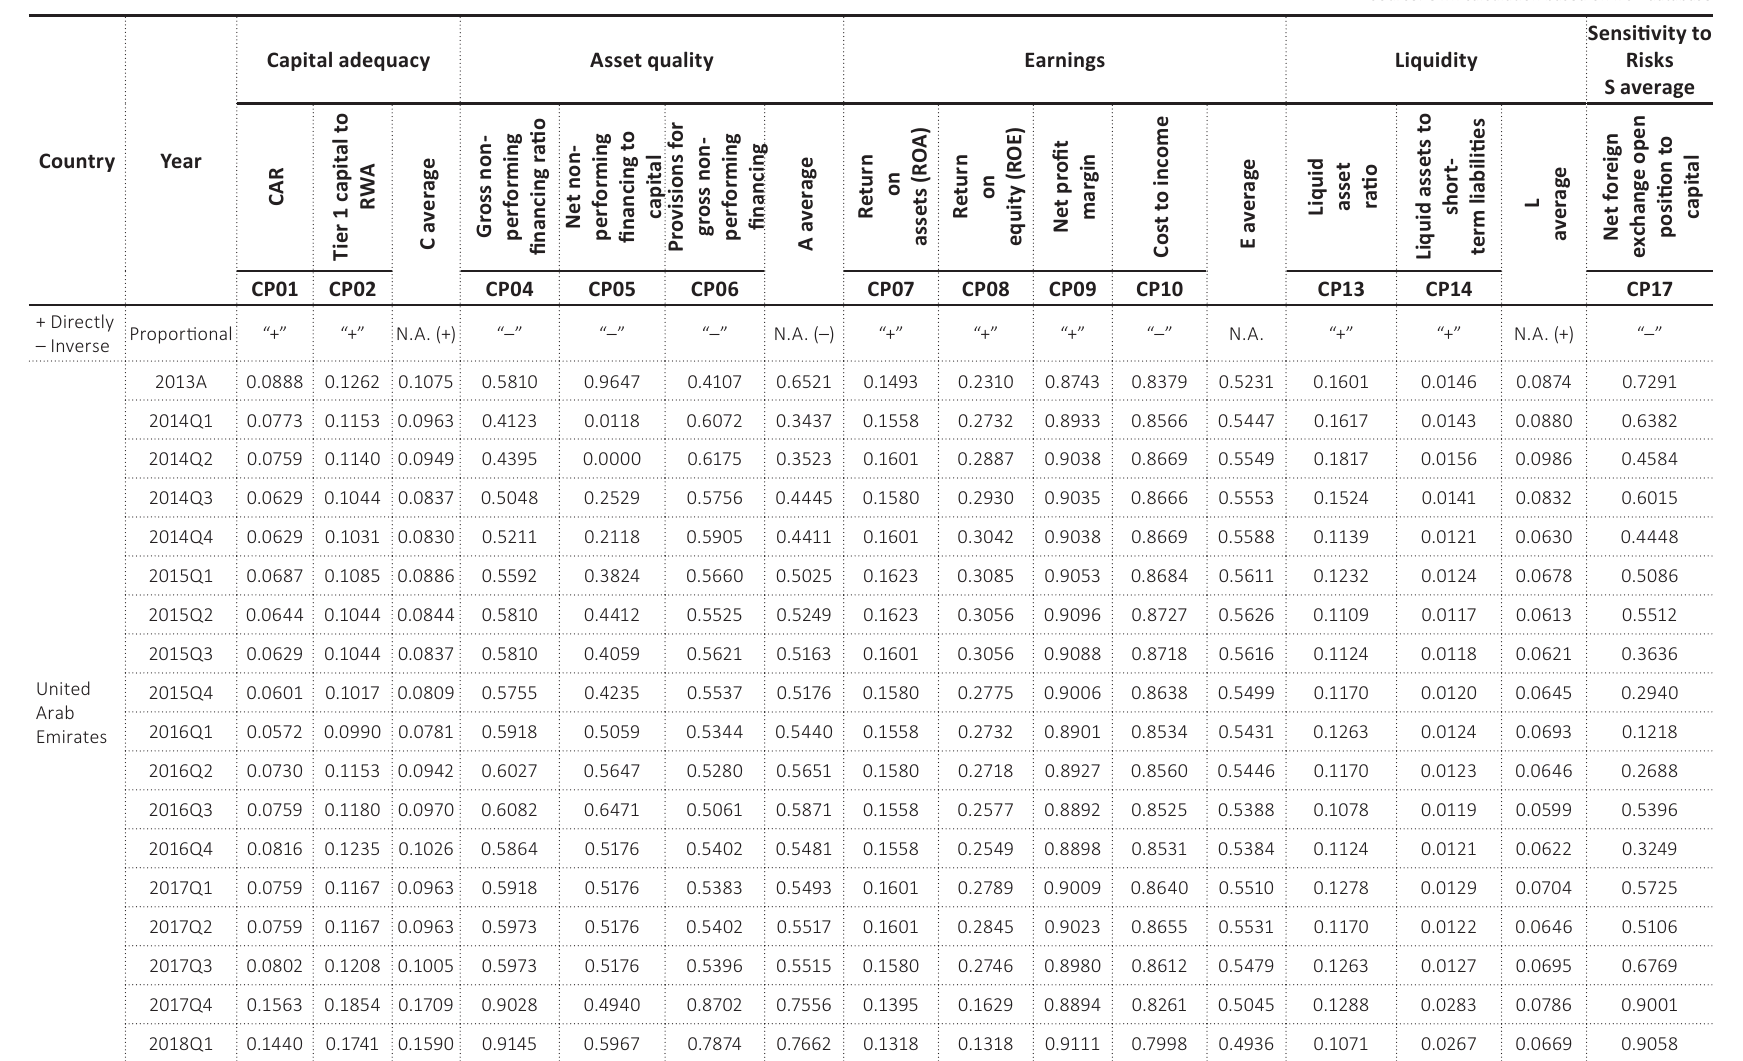
Table A6. Standard CAELS data of the United Arab Emirates Capital adequacy Asset quality Earnings Liquidity